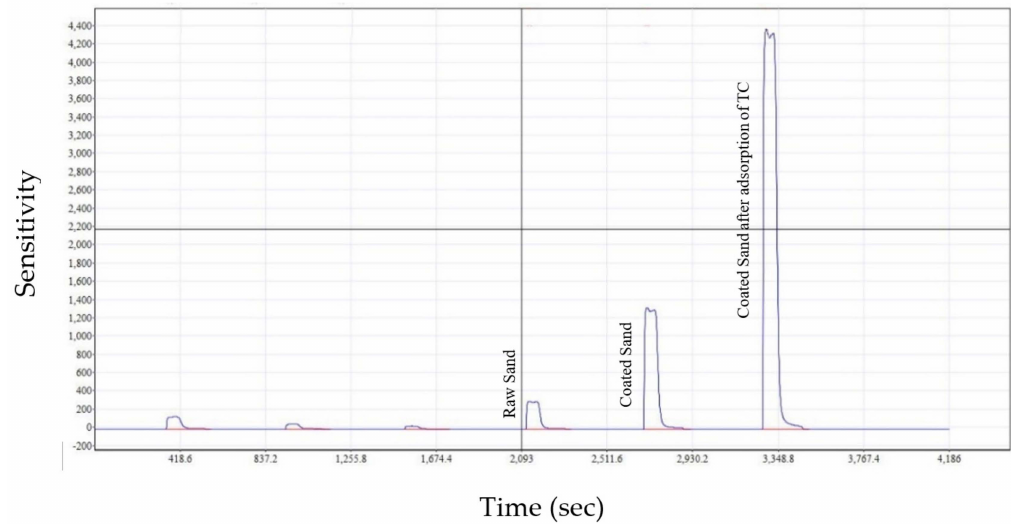
Figure 10. Total carbon for sand, coated sand, coated sand after adsorbing